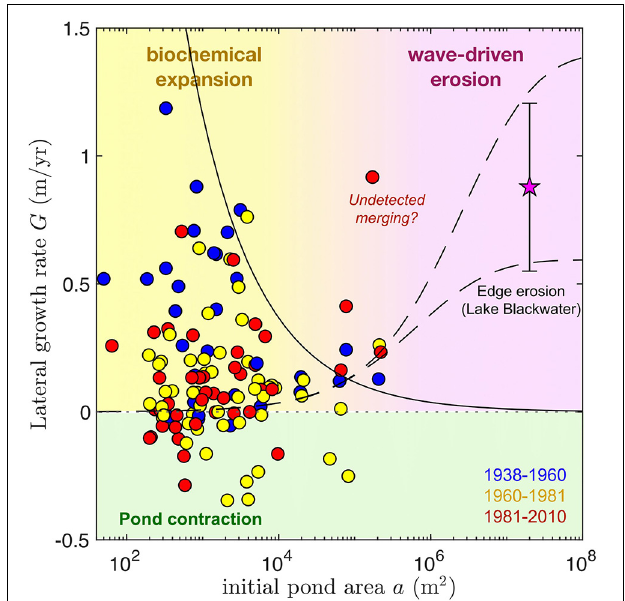
FIGURE 5 | Lateral growth rate G of single (non-merging) ponds as function of initial pond area a (circles) for the time intervals analyzed. The mean and standard deviation of the erosion rate of one edge of Lake Blackwater, along its longest axis, is also shown for comparison (star). Dashed lines correspond to a semi-empirical equation for wave-driven marsh edge erosion (Mariotti and Fagherazzi, 2013) evaluated at two characteristic pond depths, 0.3 m (lower) and 0.5 m (higher). The solid line shows the scaling of lateral growth rates corresponding to a constant area growth rate R = 150 m 2 yr − 1 (see Figure 6 ), √ π a (cid:1) . We suggest isolated pond growth assuming circular ponds: G = R / (cid:0) 2 is controlled by biochemical mechanisms below ∼ 10 5 m 2 , and by wave-driven erosion above it. Negative growth rates denoting pond contraction are highlighted in green. Given the large time spans between measurements, the central outlier could correspond to an undetected merged pond (see Figure 6